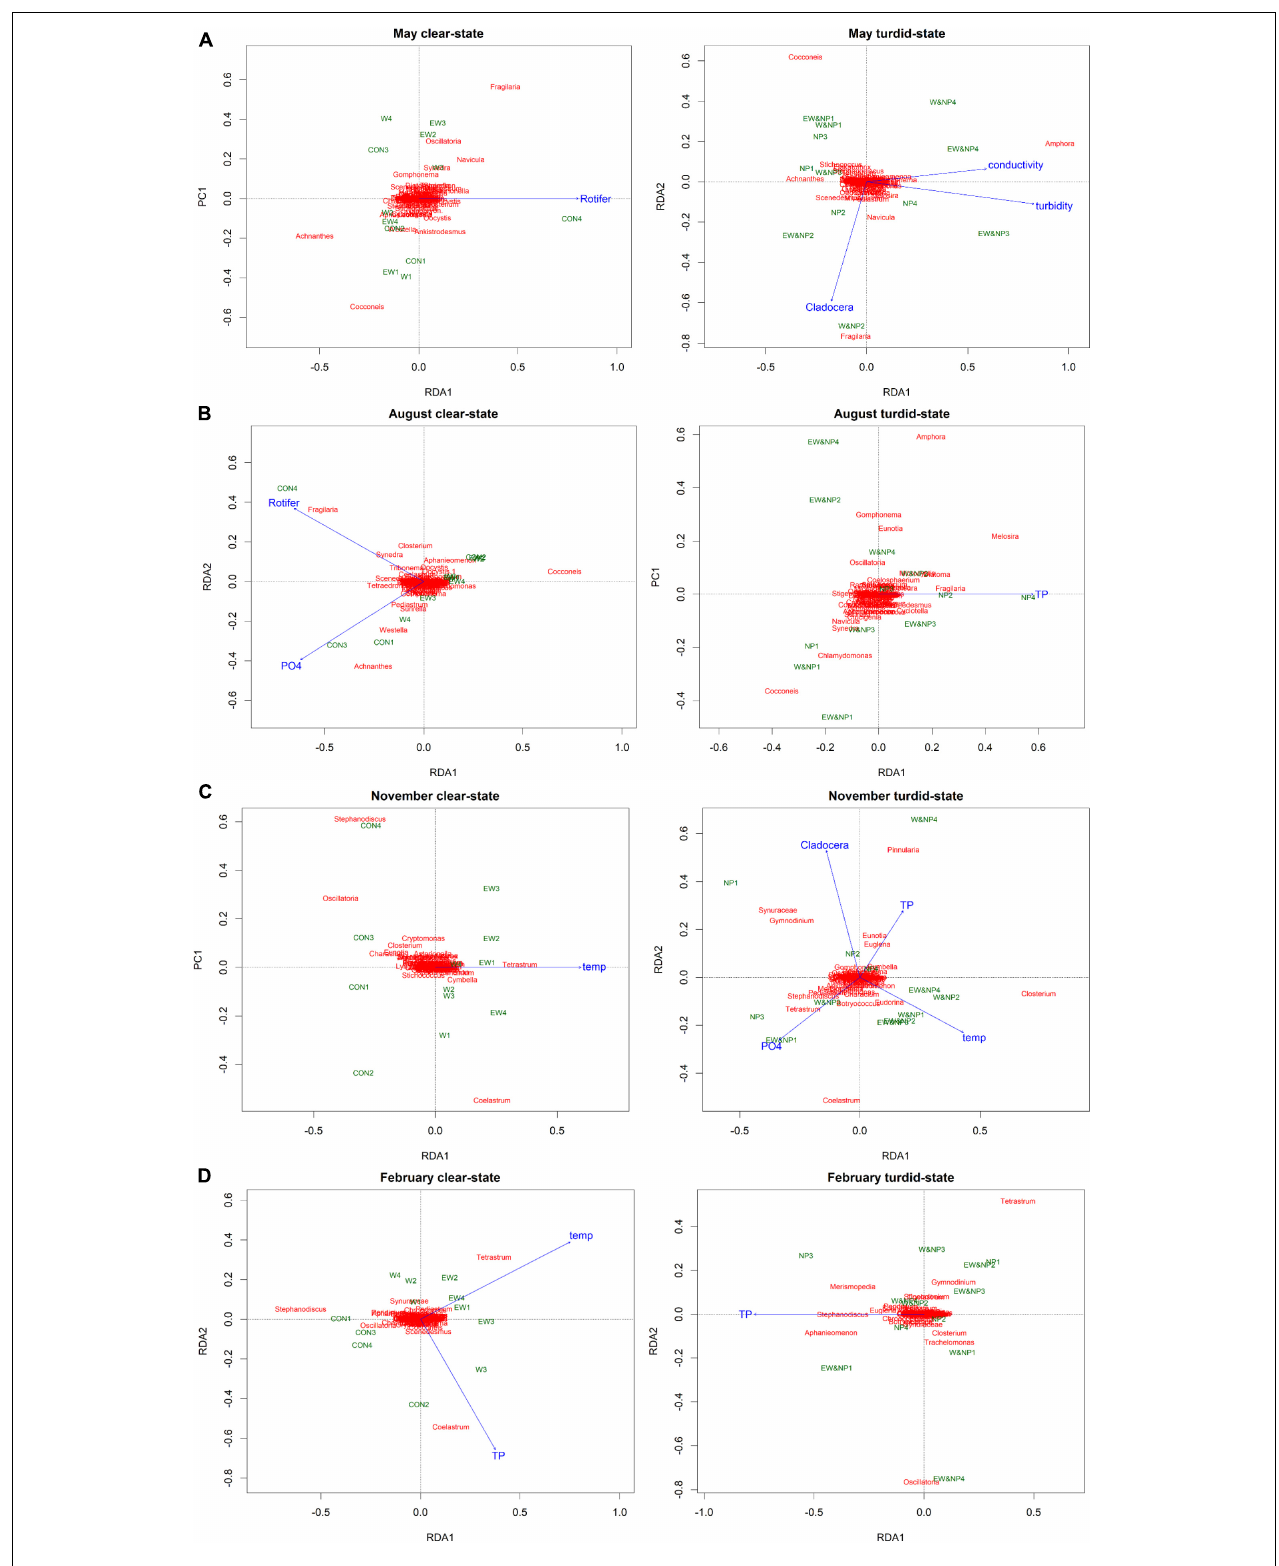
FIGURE 5 | Tri-plots of RDA results showing the differences in periphyton genera, treatments and environmental variables between the clear-low-nutrient state and the turbid-high-nutrient state in (A) May, (B) August, (C) November, and (D) February.